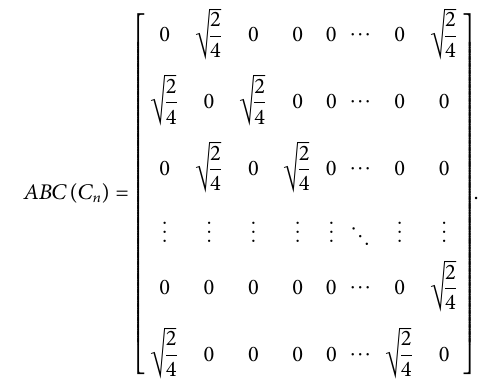
FIGURE 3 Sh B 3 ( 1 ), the 3-shadow graph of